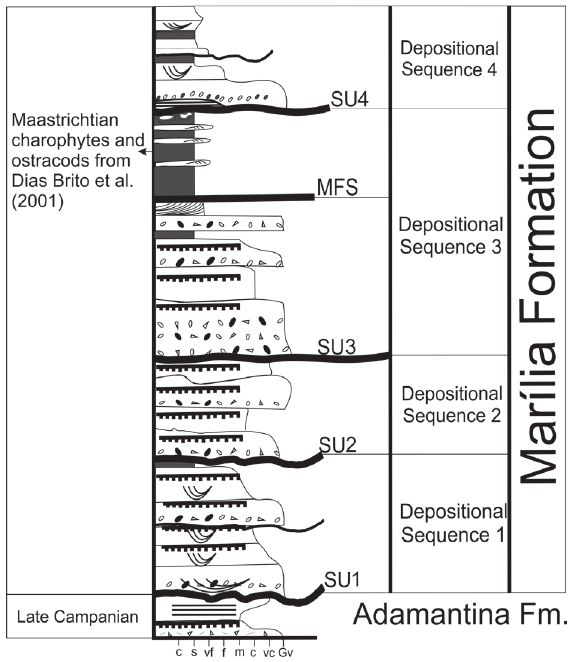
Figure 3 - Sequence stratigraphic framework of the top of the Adamantina Formation and the Marília Formation. Maxakalisaurus is from the top of the Adamatina Formation and the major Marília sauropods are from the base of the Marília Formation. There is some sauropod material from above the SU4, from the Gurinhatã-Campina Verde Road in Triângulo Mineiro region. The location of the microfossils dated by Dias- Brito et al. (2001) is indicated. SU=subaerial unconformity; MFS= maximum flooding surface. Figure by F.